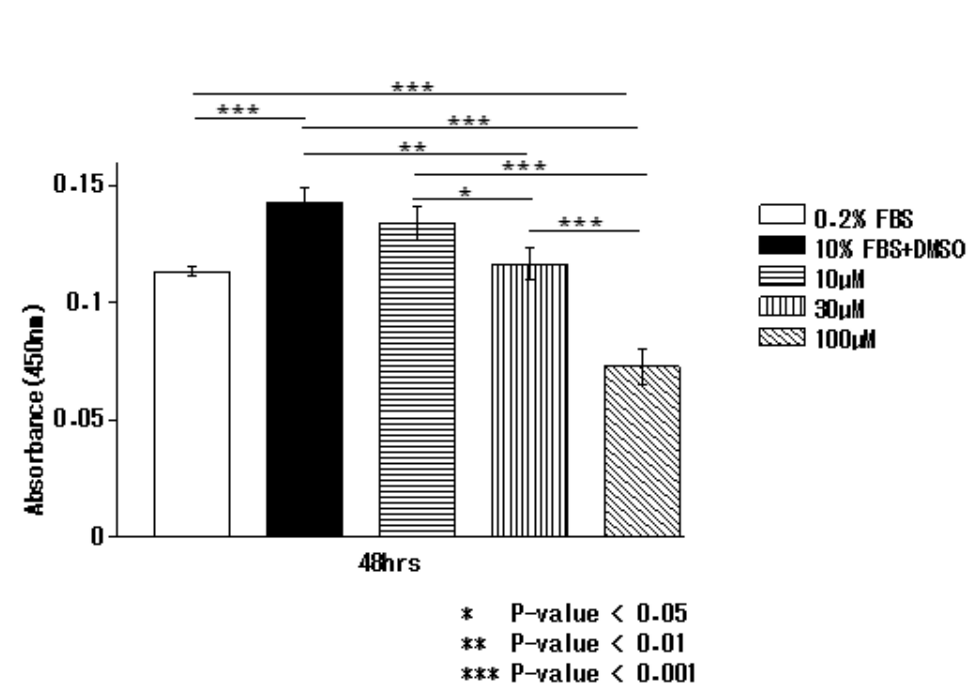
Figure 5. Galunisertib inhibits microglial proliferation in vitro. EOC 2 mouse microglial cells were treated with 0.2% FBS, 10% FBS + 0.2% DMSO, or 10, 30, or 100 µM galunisertib, a TGFβRI inhibitor. Galunisertib inhibited proliferation in a dose-dependent manner. The effect of galunisertib on EOC 2 cells was analysed by WST-1 assay at 0, 48, 72, and 96 h. P < 0.05, was considered significant (Kruskal–Wallis test). Data are presented as the mean of triplicate experiments; error bars represent the standard deviation.